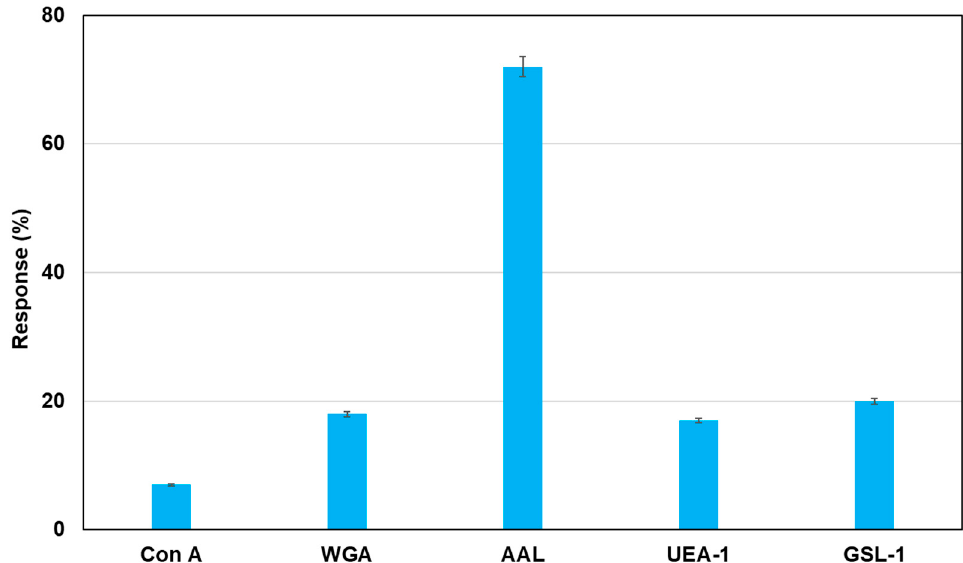
Figure 7 . Detection of glycome patterns in cell lysates from MCF-7 using fluorescent magnetic beads. The bar graph of fluorescent response following the addition of mammalian cell lines (MCF-7: 10,000 cells/ µ L). [FMB-Con A] = [FMB-WGA] = [FMB-AAL] = [FMB-UEA-1] = [FMB-GSL-1] = 10 µ g/mL; Fluorescence measured at 575 nm; Excitation wavelength, 550 nm.